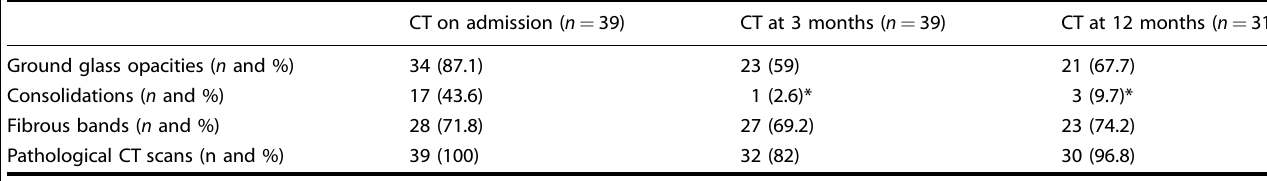
Table 2. Radiological characteristics on admission, at three-month and 1-year follow-ups.